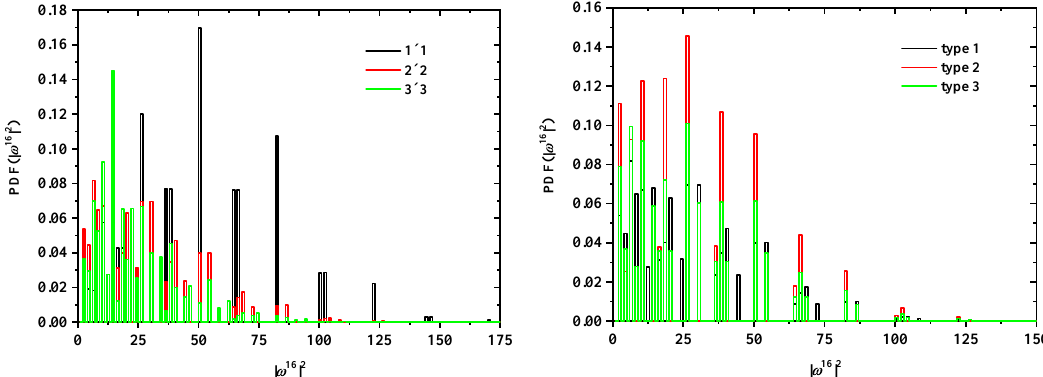
(cid:12) (cid:12) 2 for SAWs of fixed length N = 16 on restricted (cid:12) ω 16 (cid:12)